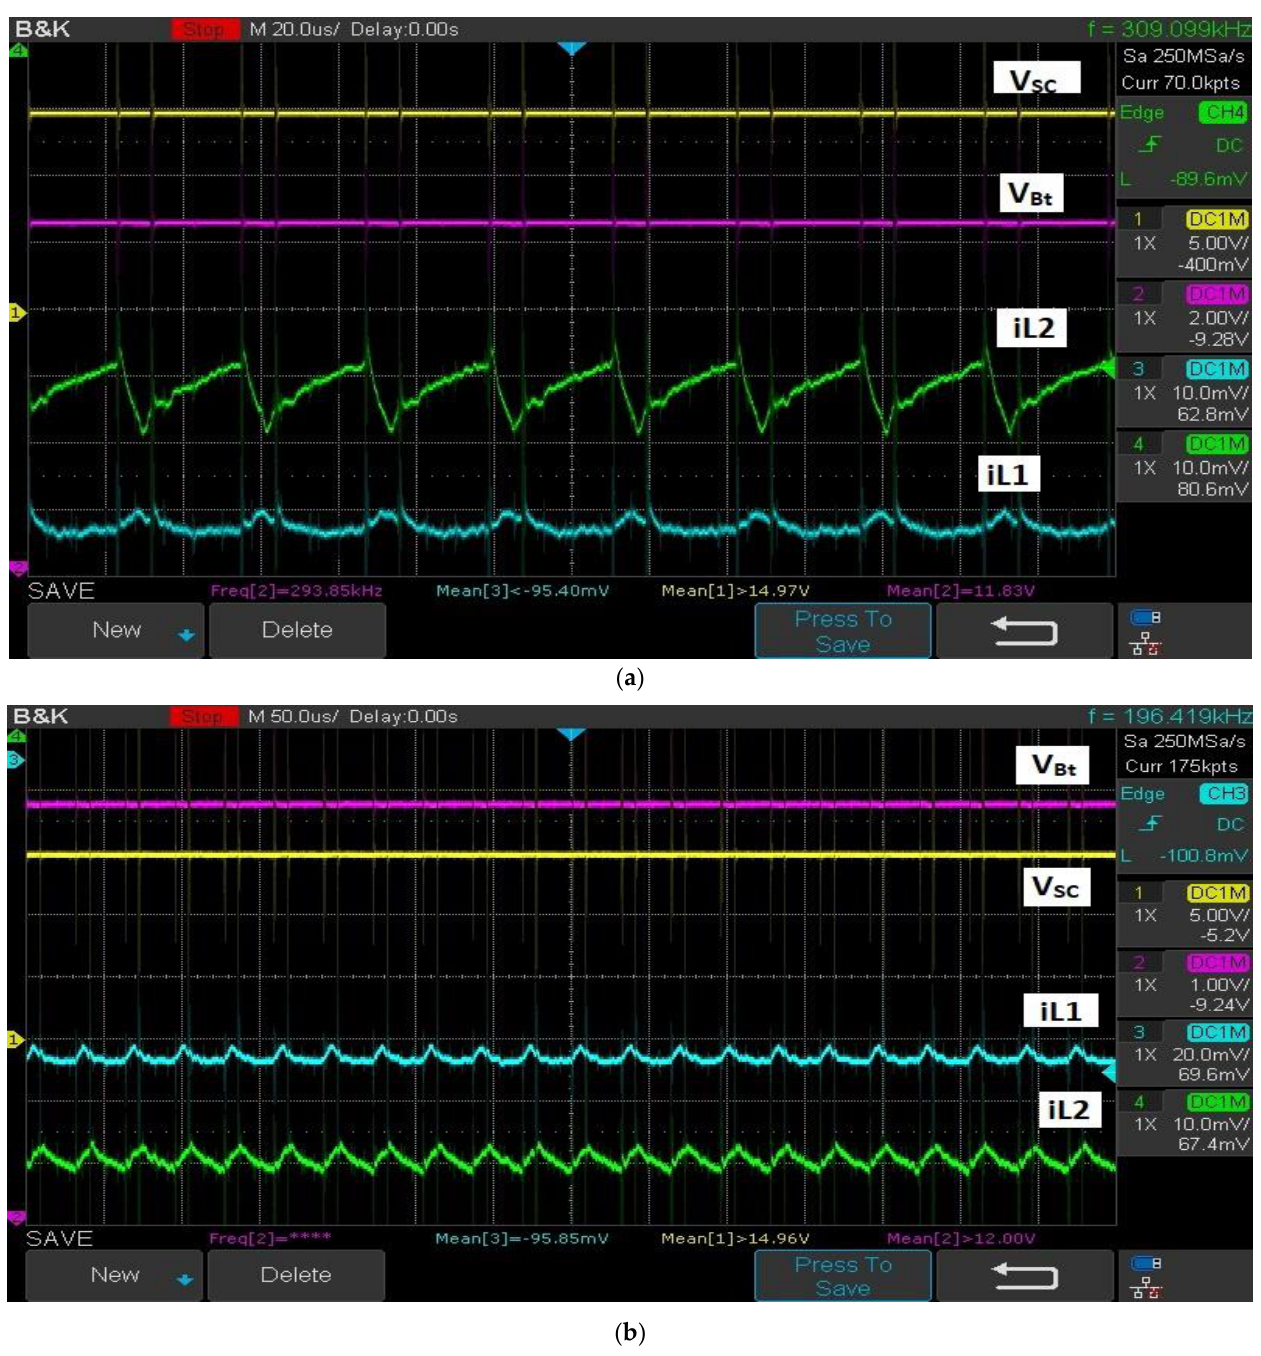
Figure 20. ( a ) Mode 3(a): charging battery from the supercapacitor using inductors L1 and L2. ( b ) Mode 3(b): Charging supercapacitor from the battery by reversing the currents in inductors L1 and L2.